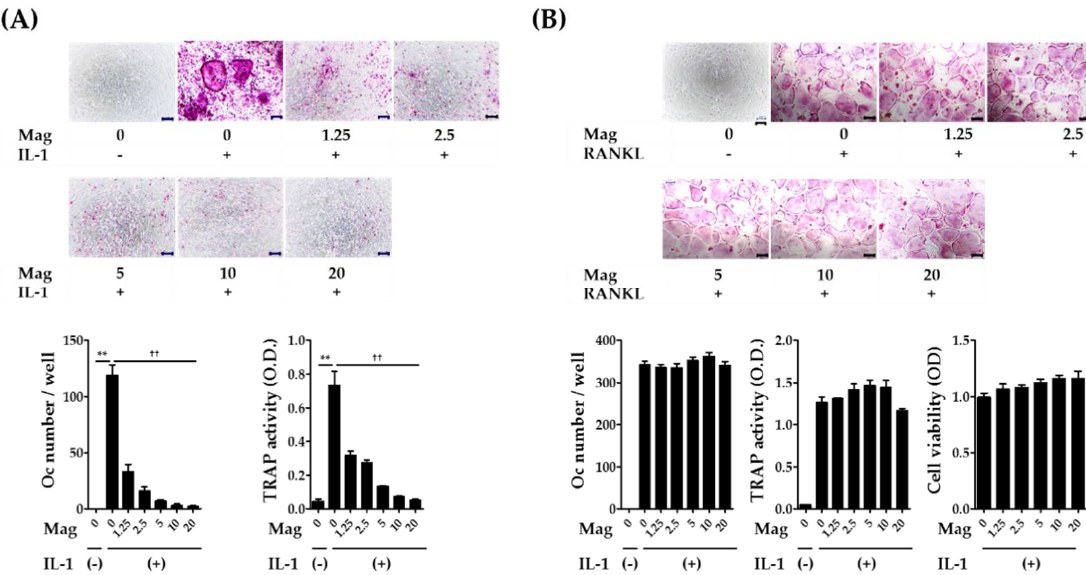
Figure 2. Magnolol inhibits osteoclast formation in co-cultures treated with IL-1. ( A ) Mouse primary osteoblasts and bone marrow cells were co-cultured in the presence of IL-1 (10 ng/mL) for seven days. Magnolol (Mag, 1.25–20 µ m) was pretreated for 1 h prior to IL-1 treatment. After fixation and TRAP staining, TRAP-positive multinucleated giant cells ( ≥ three nuclei, ≥ 50 µ m in diameter) were counted as osteoclasts. ( B ) BMMs were incubated in the presence or absence of M-CSF (30 ng/mL), RANKL (100 ng/mL), and Mag for four days. The number of osteoclasts was counted. Cell viability was determined via Cell Counting Kit-8 assay. Scale bar, 100 µ m. ** p < 0.01 vs. IL-1-untreated control. †† p < 0.01 vs. magnolol-untreated control.